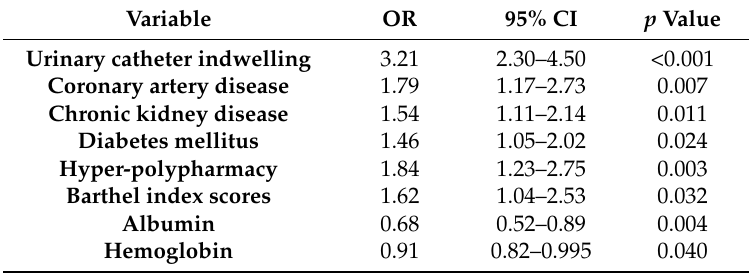
Table 3. Age and sex-adjusted multiple logistic regression analysis of risk factors for